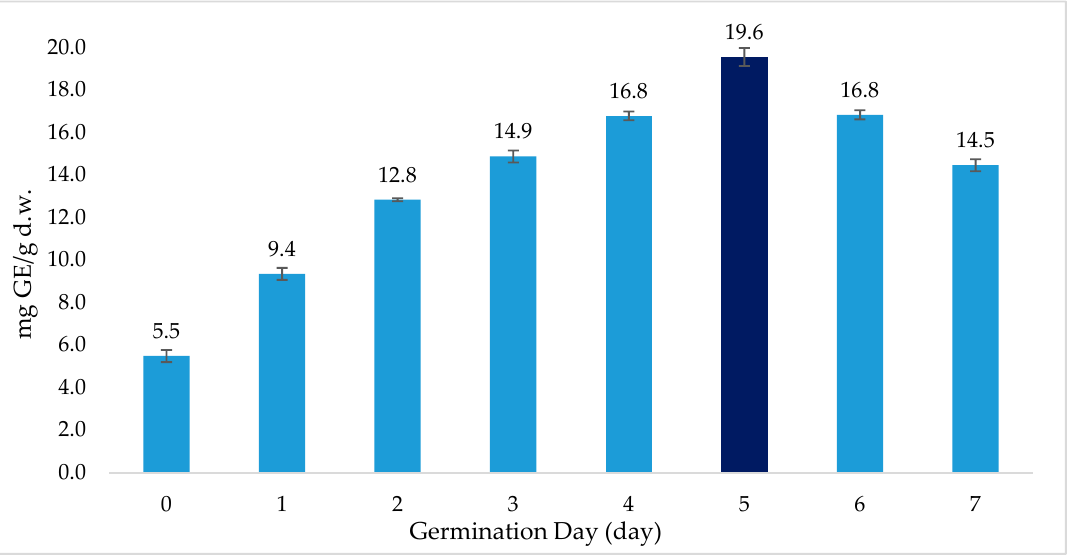
Figure 7. Effect of germination day. Figure 7. E ff ect of germination